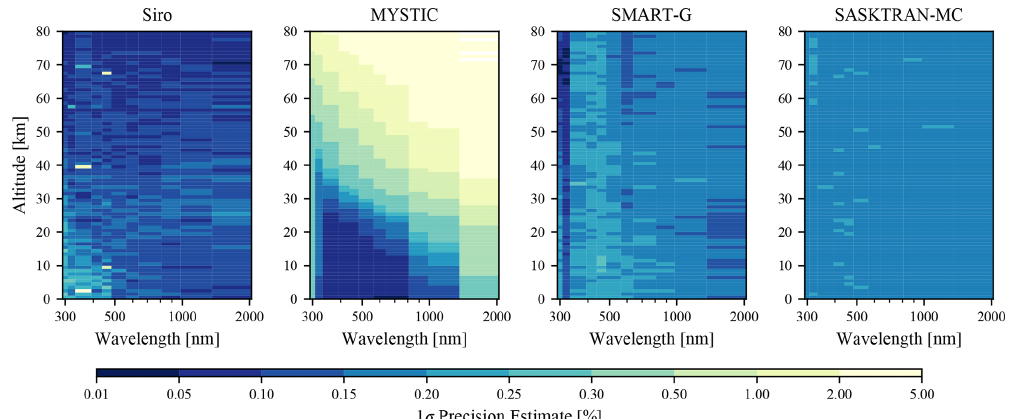
Figure 10. Precision estimates for the MC models with multiple scattering, Rayleigh scattering + ozone absorption + stratospheric aerosol scattering, SZA = 70 ◦ , SAA = 30 ◦ , and a Lambertian surface reflectance of 1. Precision estimates for MYSTIC, SASKTRAN-MC, and SMART-G were taken from the model output. Siro precision was estimated by running the above scenario 20 times and taking the standard